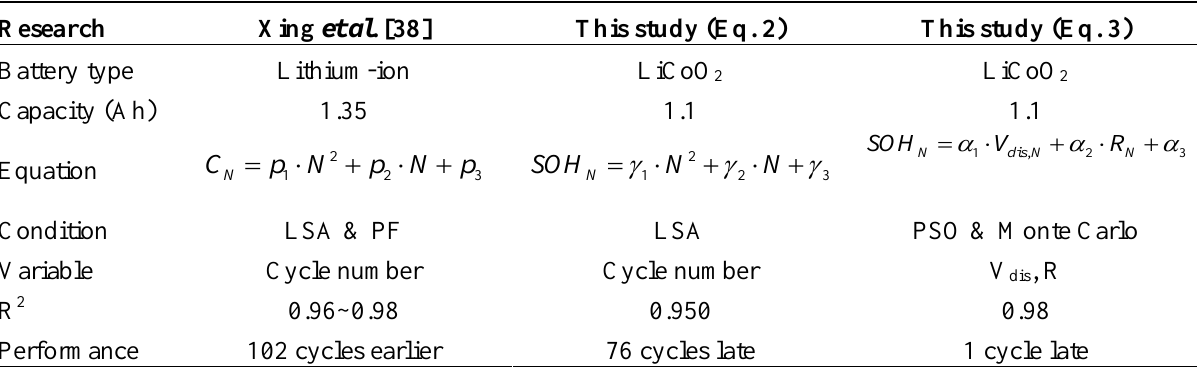
Figure 9. Predictions with updating function in bi-variable polynomial and exponential model. Table 3. Comparison of the results of polynomial model.